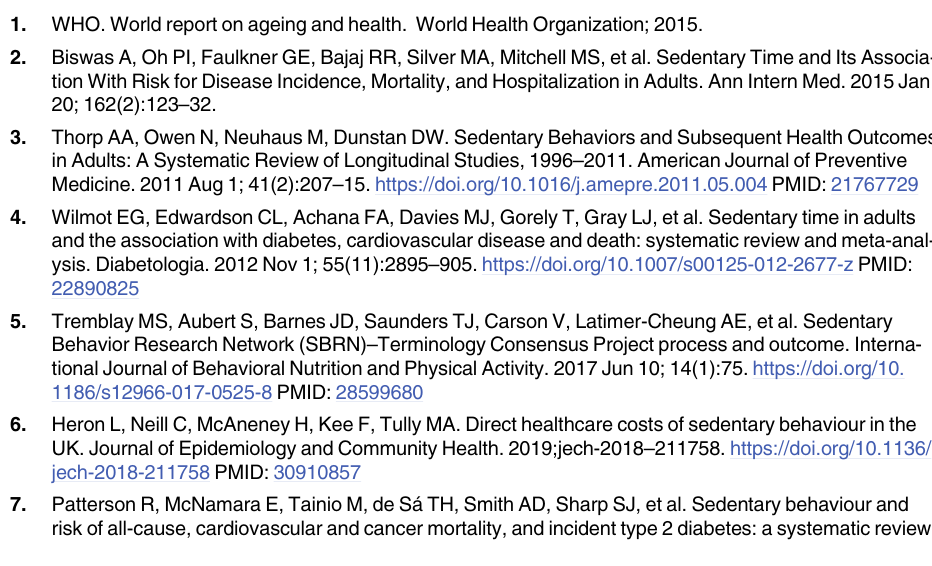
S4 Table. Health Information Delivery